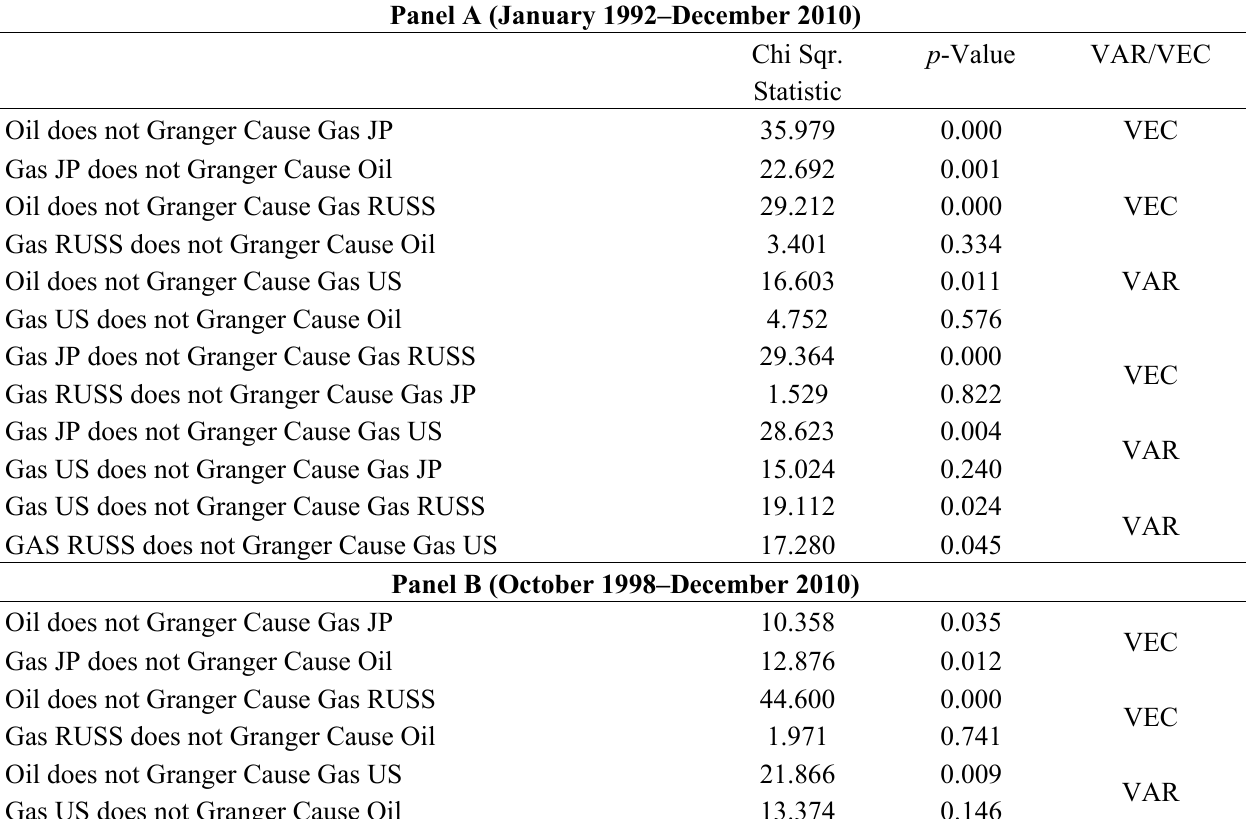
Table 4. Pairwise Granger causality